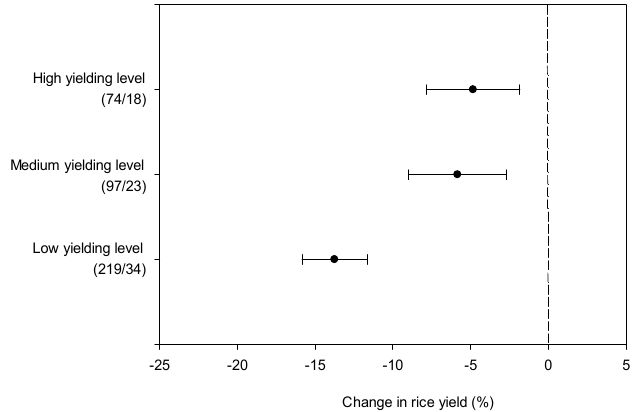
Figure 6. Percentage changes in direct-seeded rice yield relative to transplanted rice for di ff erent yielding levels. The number of paired observations / number of studies included in each dataset are presented in parenthesis. Significant di ff erences by categories are based on randomization